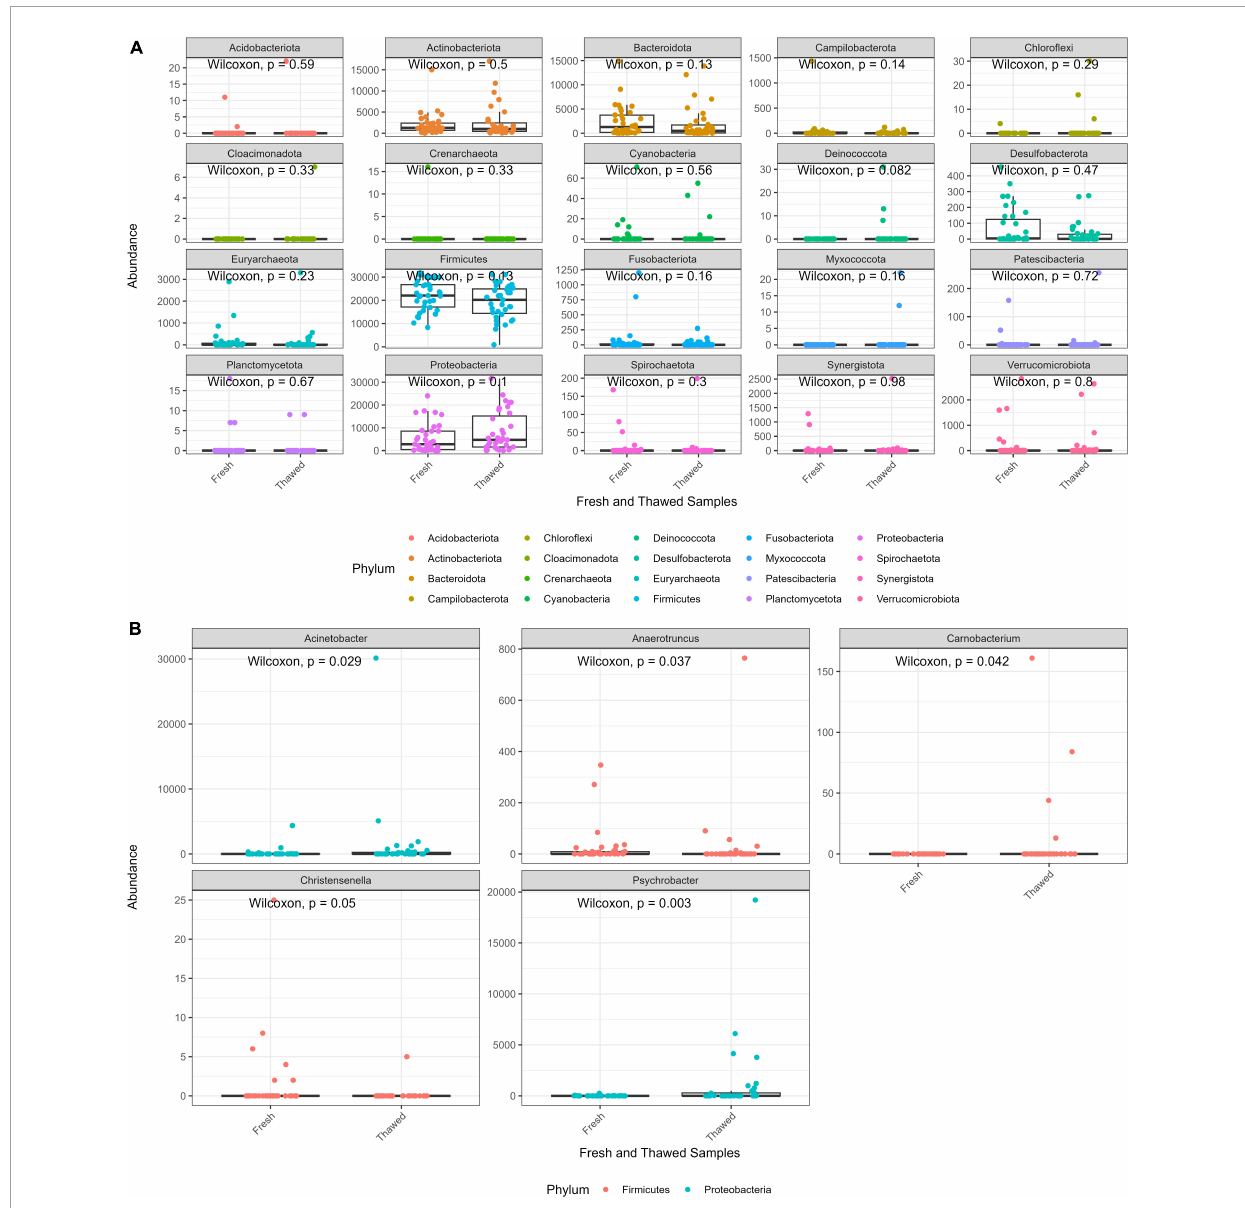
FIGURE2 Abundance plot of fresh and thawed samples at phylum level (A) and taxa at genus level (B) with abundance significantly different across fresh and thawed